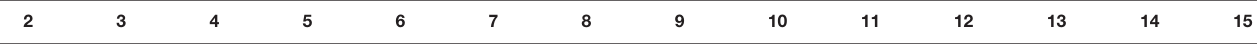
TABLE 5 | Full correlation